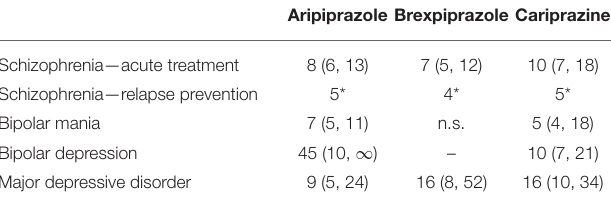
TABLE 5 | Comparison of clinical efficacy of DRPAs vs. placebo using number needed to treat for therapeutic response (NNT, 95% CI) in schizophrenia, acute mania (7), bipolar depression (71, 72), and major depression (70). Aripiprazole Brexpiprazole